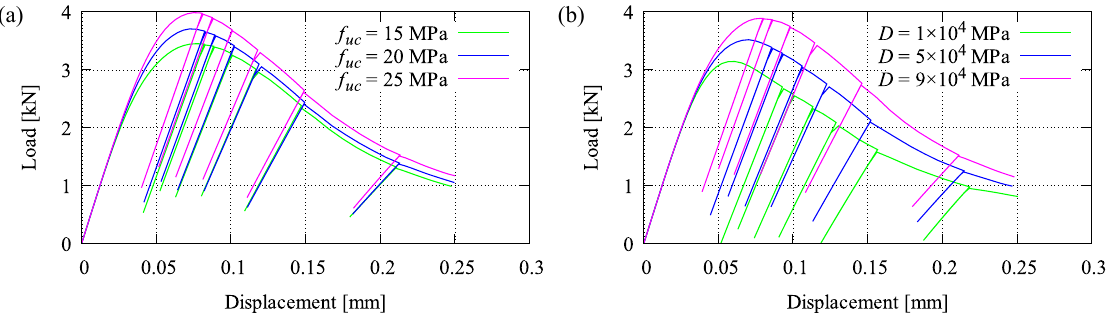
Figure 11. Effect of parameters with respect to the load-displacement relation: ( a ) compressive strength f uc and ( b ) hardening stiffness D